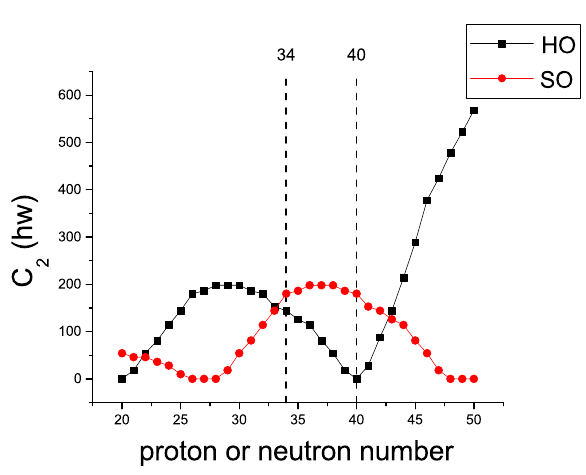
Figure 3. The same as Fig. 1. An island of shape coexistence is predicted within proton or neutron numbers 34 − 40.